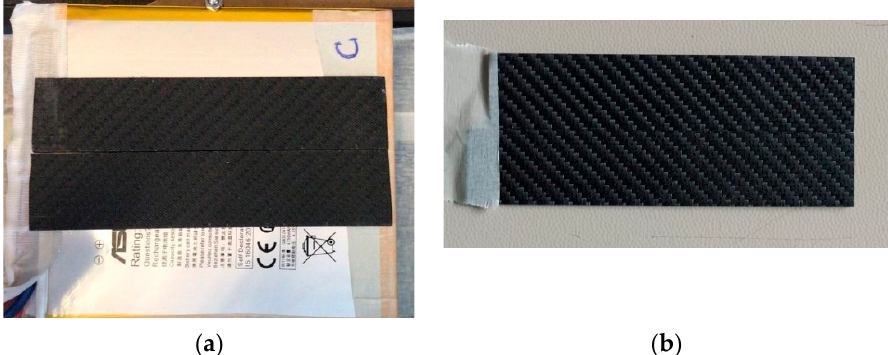
Figure 2. Image of the battery with the carbon layer ( a ) and of the graphene layer before the assembling ( b ). Table 1. Values of conductivity.